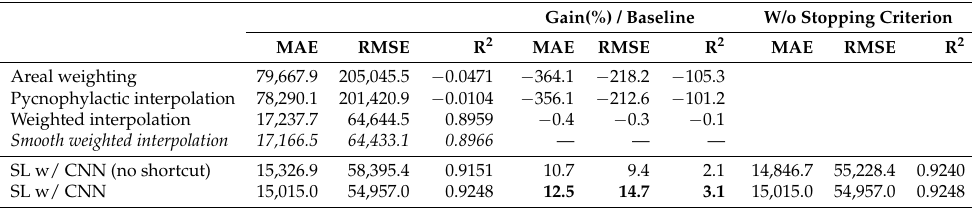
Table 4. Results obtained with different disaggregation methods for the overall amount of national withdrawals on automated teller machines.